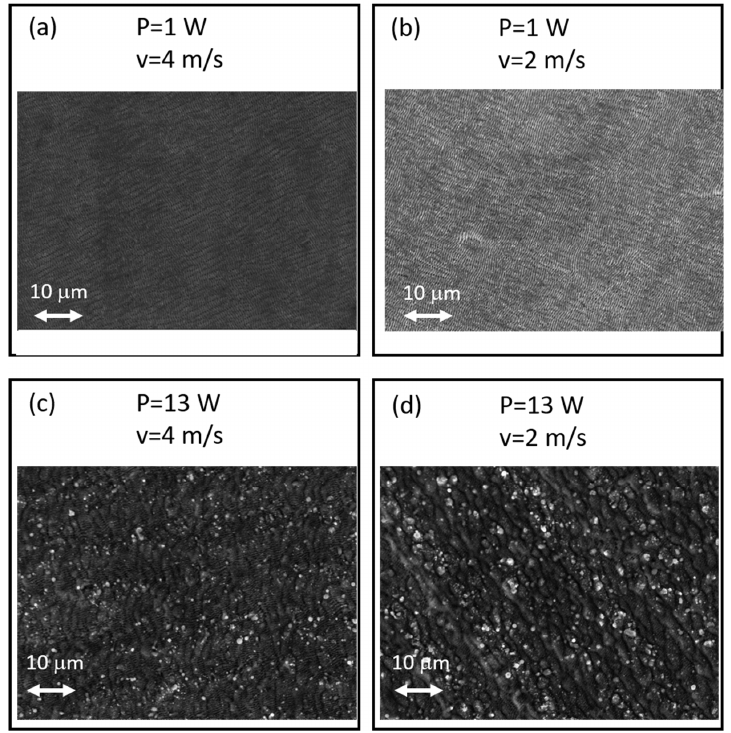
Figure 3. SEM images of the laser textured surfaces, processed at P = 1 W, v = 4 m/s ( a ); P = 1 W, v = 2 m/s ( b ); P = 13 W, v = 4 m/s ( c ); and P = 13 W, v = 2 m/s ( d ). SEM images were acquired at low magnification (500×).